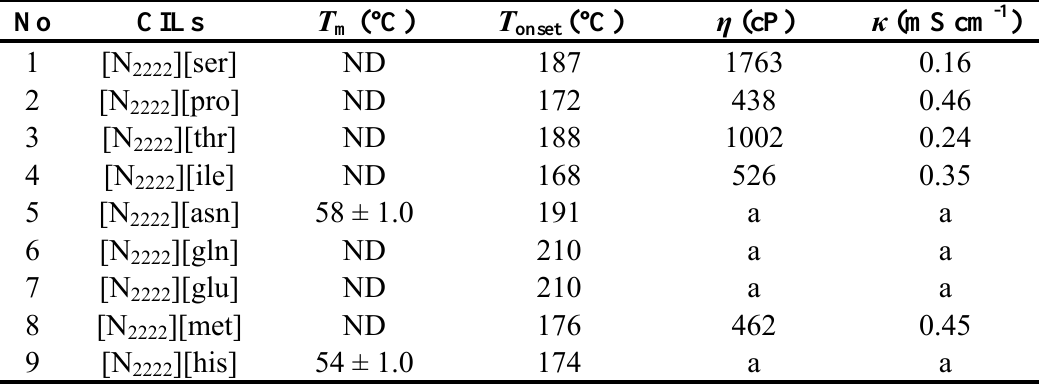
Table 1. The physico-chemical properties of tetraethylammonium-based chiral ionic liquids.